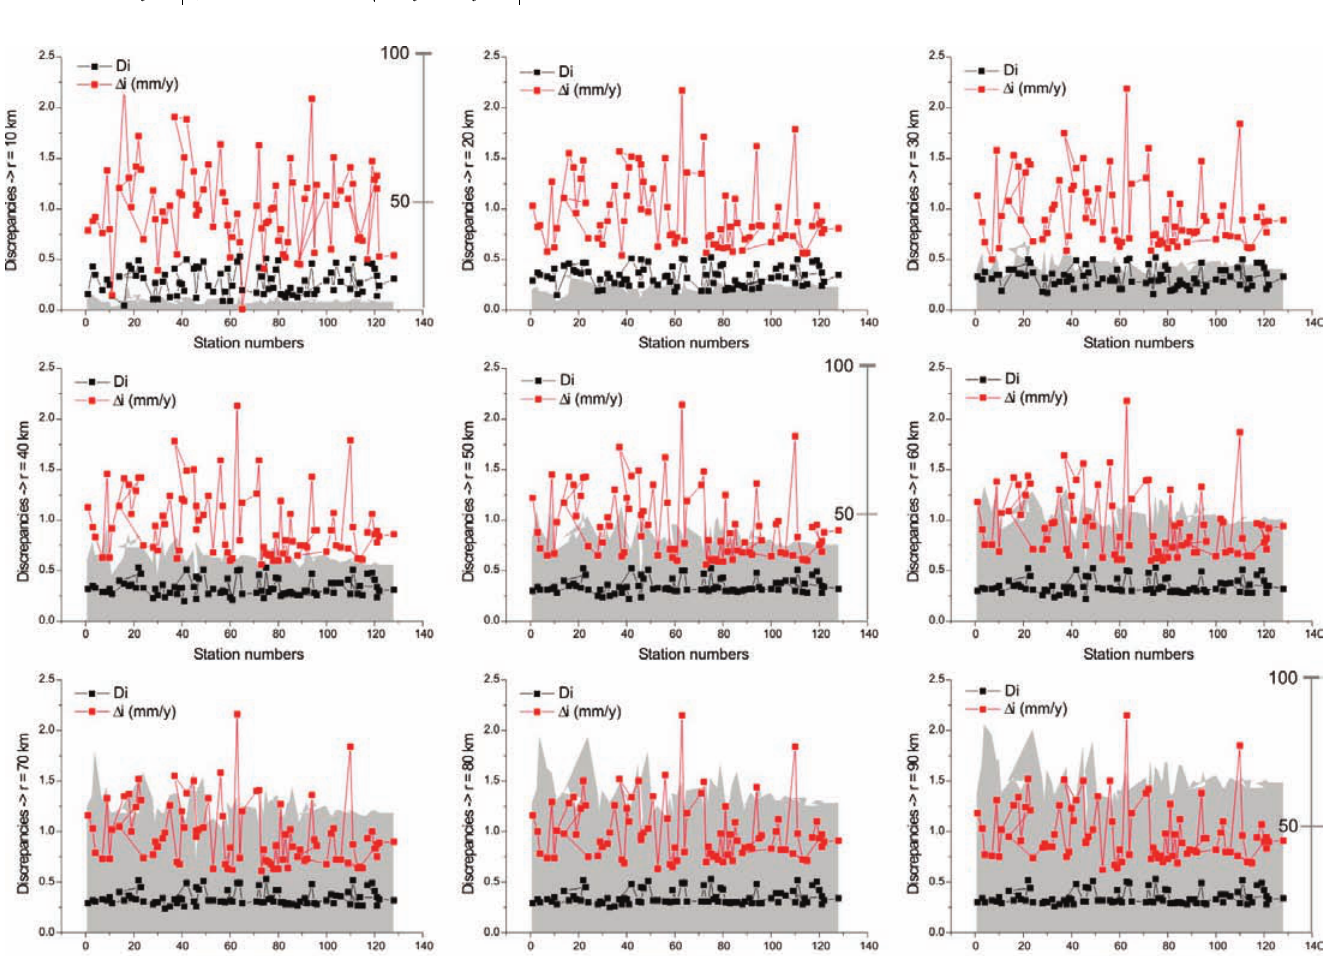
Figure 9. Distributions of D and D computed on different search radii from 10 km to 90 km. Gray shading: number of j -stations around each i -stations based i i on the search radii. For station numbers, see Table 1.